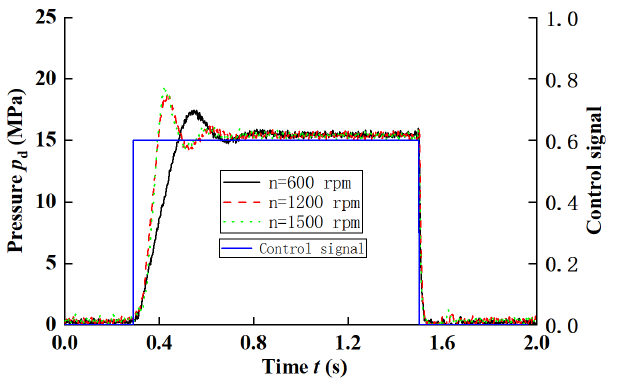
Figure 10. Dynamic characteristic curve of pressures under different speeds.